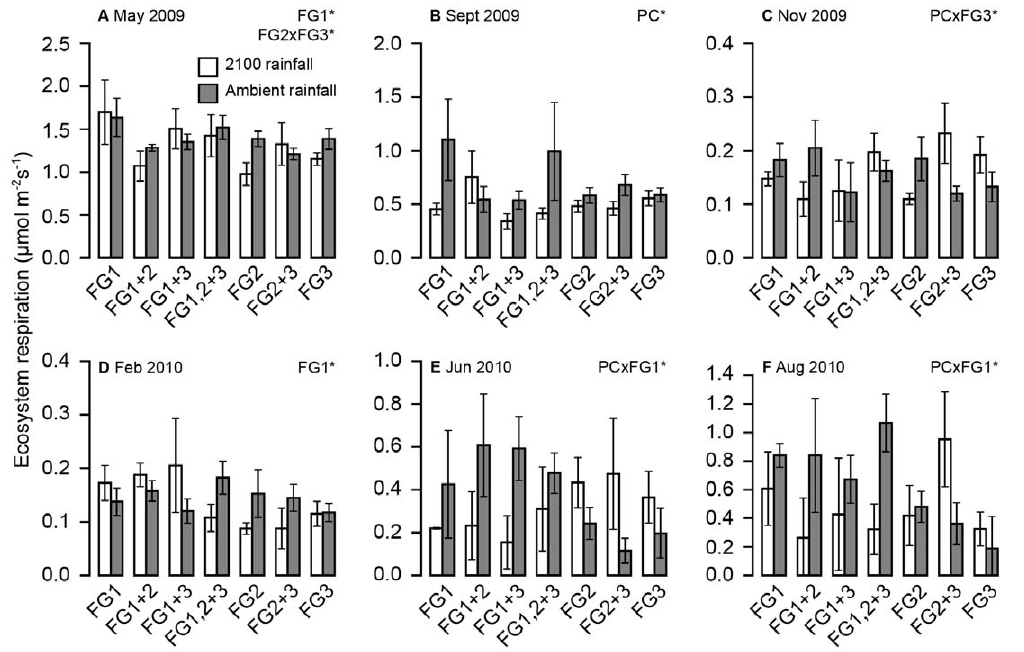
Figure 4. Effect of precipitation change and functional identity on ecosystem respiration at different time points. The response of ecosystem respiration to precipitation change (PC) and functional group (FG) identity at six time points through the experiment. a) May 2009 (presence/absence of FG1 F 1,42 =4.72, p=0.036, interaction between FG2 and FG3, F 1,42 =5.031, p=0.03), b) September 2009 (PC F 1,42 =4.596, p=0.038), c) November 2009, (interaction between PC and FG3 F 1,42 =7.165, p=0.010), d) February 2010 (FG1, F 1,45 =4.521 , p=0.039), e) June 2010 (interaction between PC and FG1, F 1,45 =5.80, p=0.020) f) August 2010 (interaction between PC and FG1 F 1,45 =6.46, p=0.015).